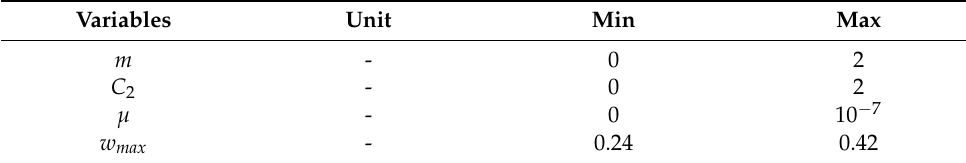
Table 2. Assumed parameter ranges ( m , C 2 , µ , w max